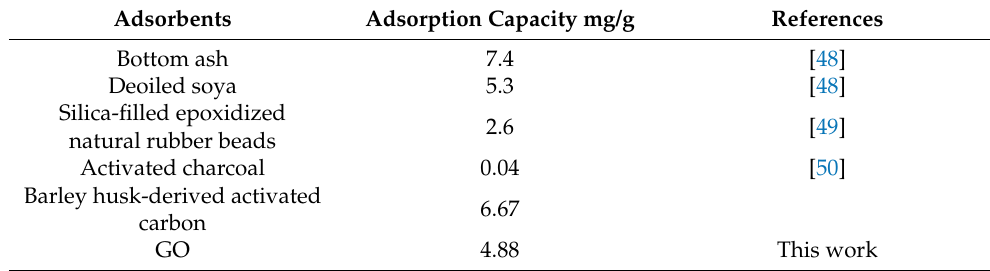
Table 4. Adsorption capacities of some adsorbent materials for the removal of dyes from